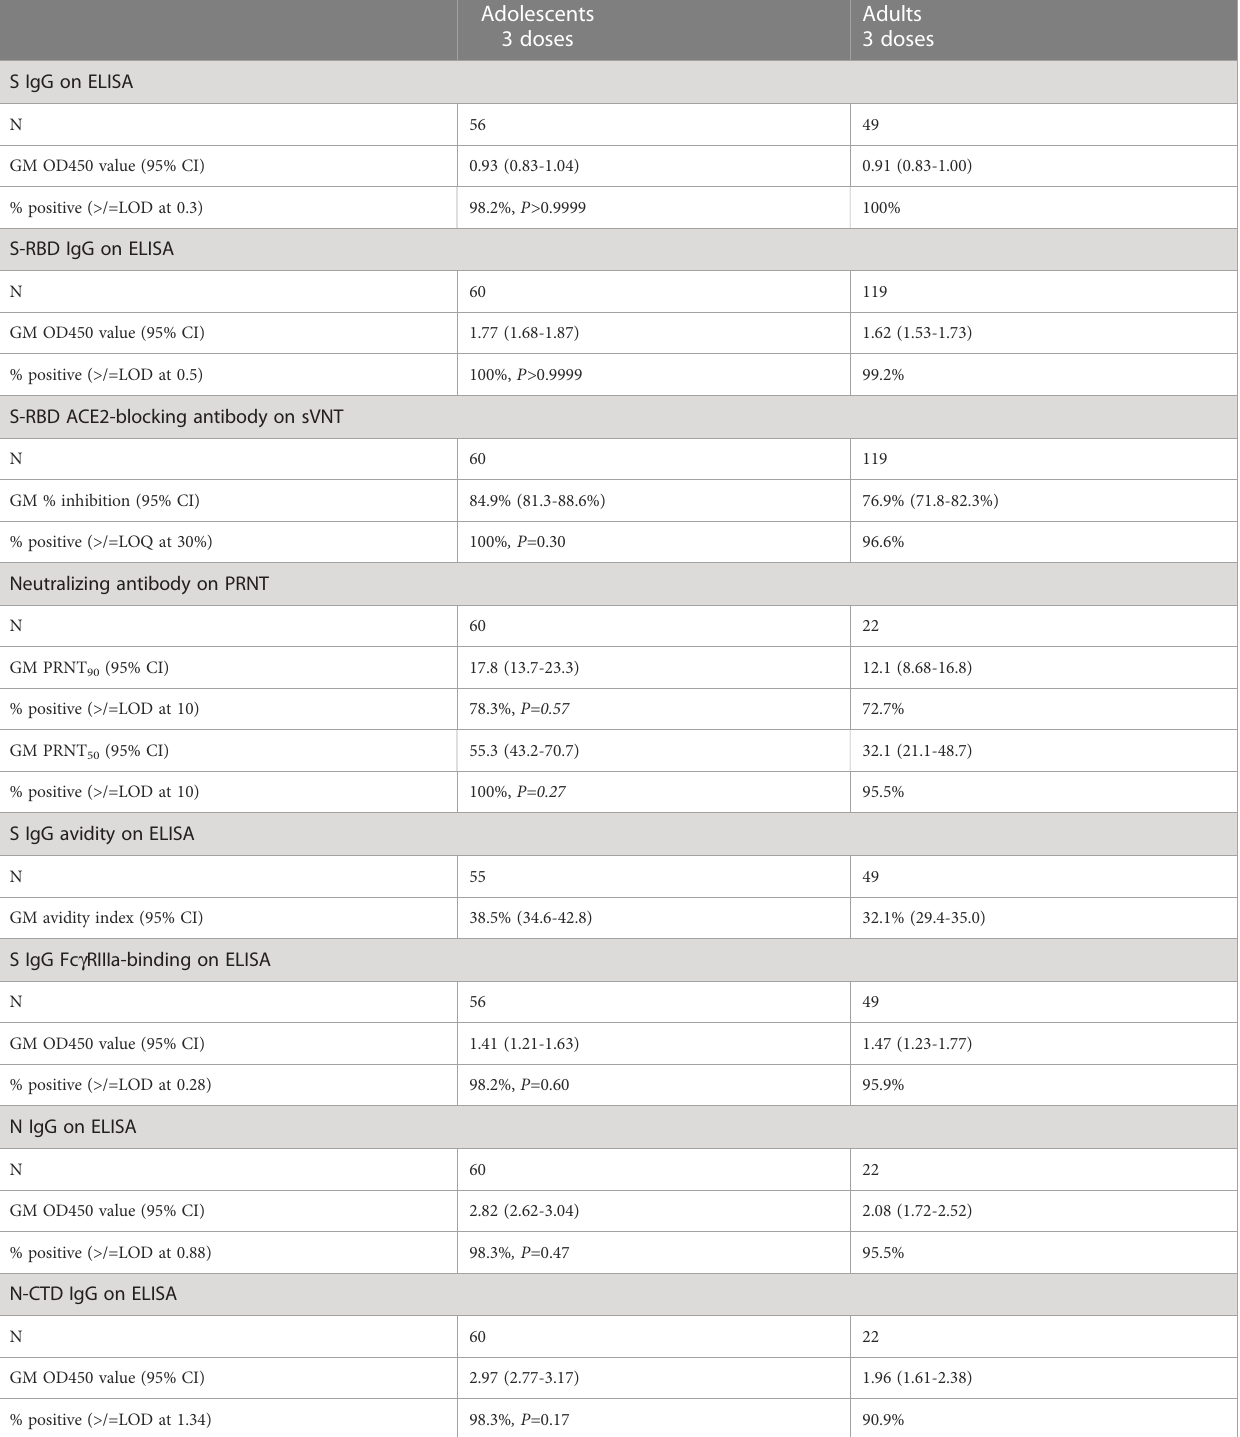
TABLE 1 Humoral immunogenicity outcomes against wild-type SARS-CoV-2 after the third dose of CoronaVac in evaluable analysis